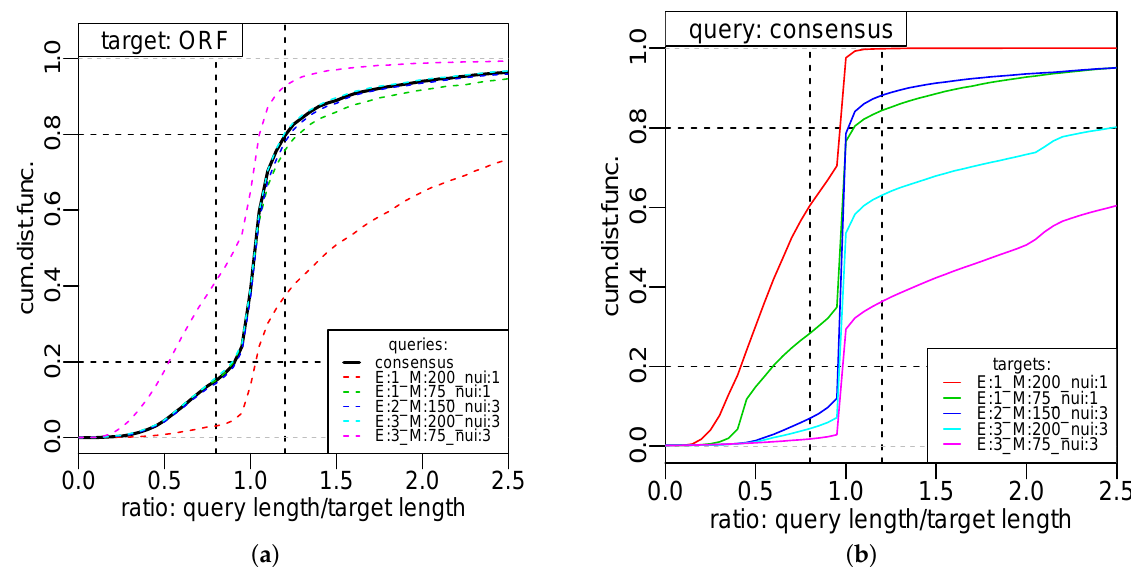
Figure 4. Quantitative evaluation of the consensus of genome-wide transcriptome segmentations of RNA-seq data from S. cerevisae from ref. [11]. ( a ) Cumulative distribution function of the length ratios r between overlapping segments and previously annotated ORF transcripts [36]. A ratio of r = 1 indicates a good match. The consensus (black solid line) of five representative segmentations (colored dashed lines) by segmenTier with widely different parameter settings (as indicated in Figure 2d of Reference [11]) is at least on par with the best individual segmentation. ( b ) Overlap of the consensus with the five different input segmentations. The individual segmentations share between about 30% and 70% of their segments with the consensus (vertical jump at r = 1). The consensus was computed with e ( z ) = z 2